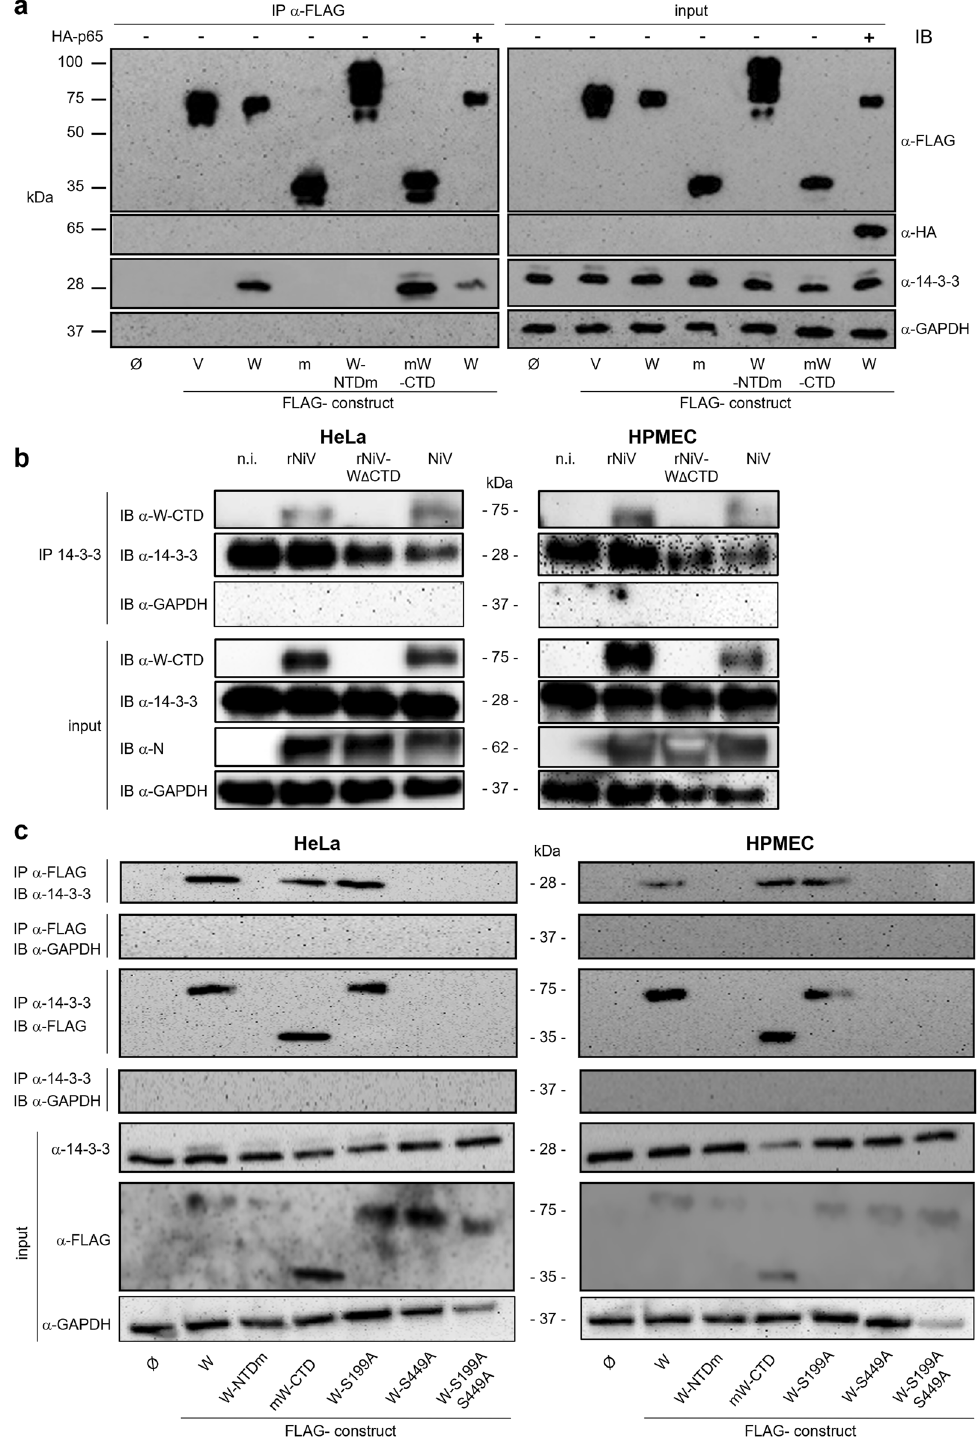
Fig. 3 W protein requires CTD-S499 to interact with 14-3-3 in transfected and infected cells. HeLa cells ( a – c ) or HPMECs ( b , c ) were transfected with a plasmid encoding FLAG-tagged V or truncated/variant W proteins, fused or not with mCherry (shortened as m), or HA-p65; an empty vector (Ø) and a plasmid encoding FLAG-mCherry (m) were used as controls. a Coimmunoprecipitation of endogenous 14-3-3 protein or exogenous HA-p65 with FLAG-tag NiV proteins (IP) using anti-FLAG antibodies bound to magnetic beads and detected by western blotting (IB) using rabbit anti-pan 14-3-3 or mouse anti- HA antibodies. b HeLa and HPMECs were mock-infected (n.i.) or infected with rNiV, rNiV-W Δ CTD , or wt NiV at MOI = 3. Cells were lysed 24 h later and immunoprecipitation was performed using anti-pan 14-3-3 antibodies coupled to magnetic beads. Input cell extracts and the eluate from beads were analyzed by western blotting using anti-NiV N, anti-W-CTD, anti-14-3-3, and anti-GAPDH antibodies. c Coimmunoprecipitation of endogenous 14-3-3 and FLAG-tagged W and W variant proteins in transfected HeLa and HPMECs was performed using either anti-pan 14-3-3 or anti-FLAG antibodies, and analyzed by western blotting as in a